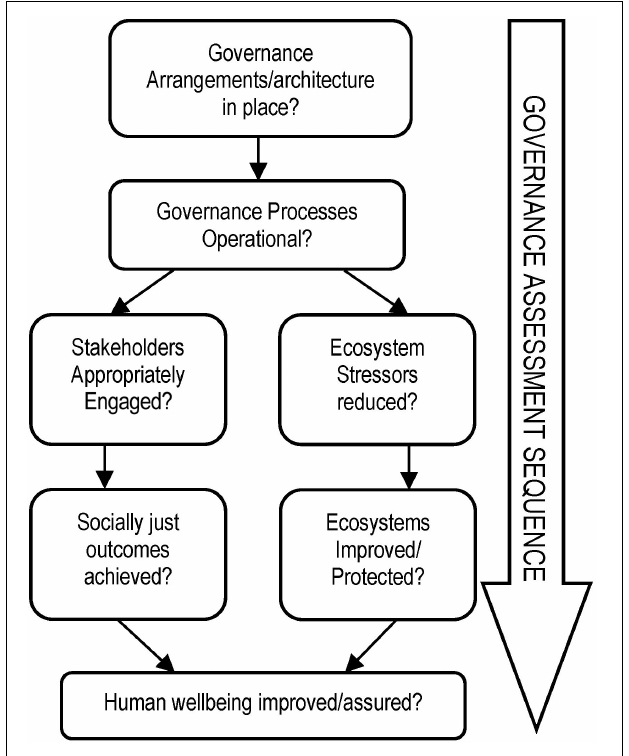
FIGURE 2 | Expanded global environment facility international waters indicator framework from Mahon et al.